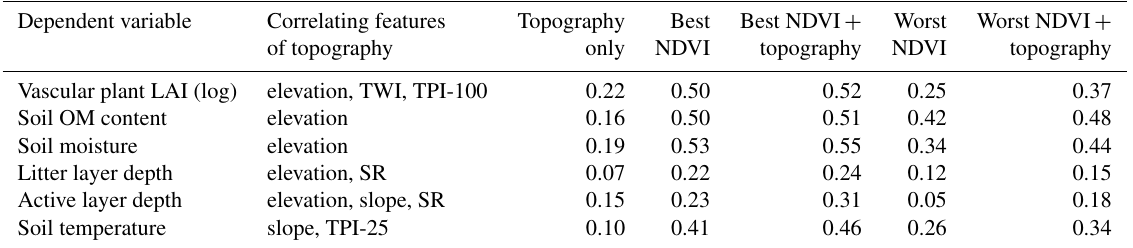
Table 4. Coefficients of determination ( R 2 ) of regression models that included those topographical features that correlated statistically significantly ( P < 0 . 05) with the dependent variable, the best or worst NDVI predictor (Figs. 12 and 13) and the best or worst NDVI predictor amended with the topographic